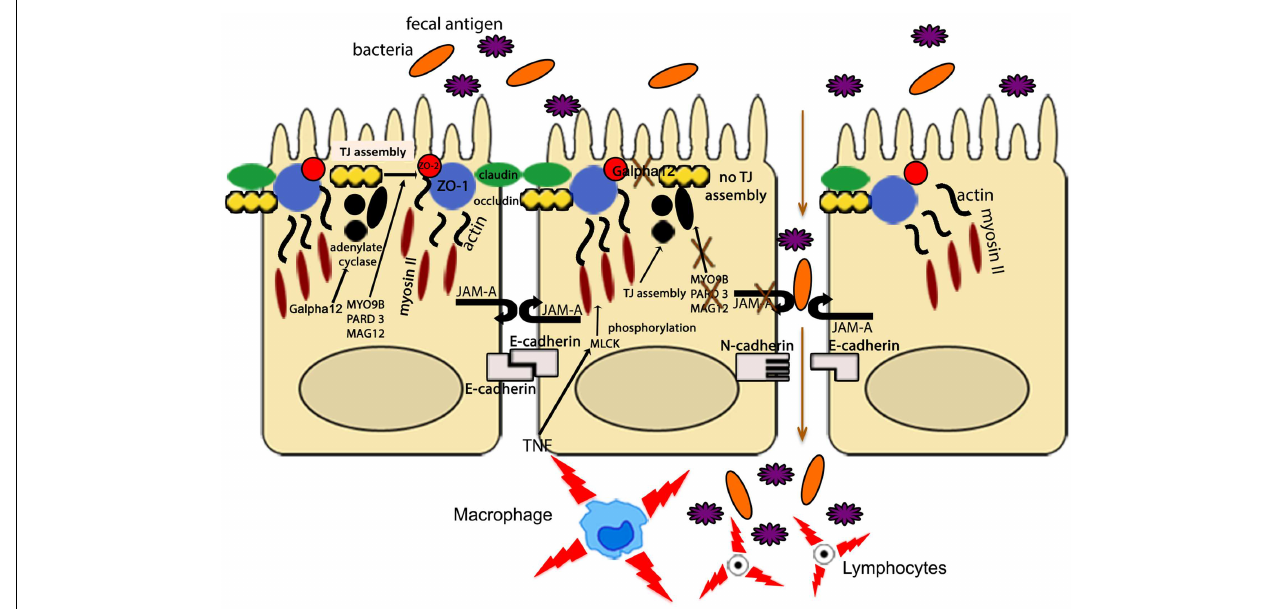
assembly; phosphorylation of myosin II through MLCK activation byTNF leads toTJ disassembly. Lack of junctional proteins, such as JAM-A, or altered expression and/or pairing (e.g., dominant negative N-cadherin, claudin-2 overexpression) leads to increased epithelial permeability, facilitating translocation of luminal bacteria, and antigens and exposure to the mucosal adaptive immune